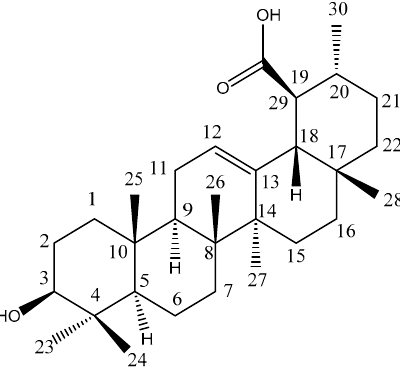
Figure 1. Chemical structure of